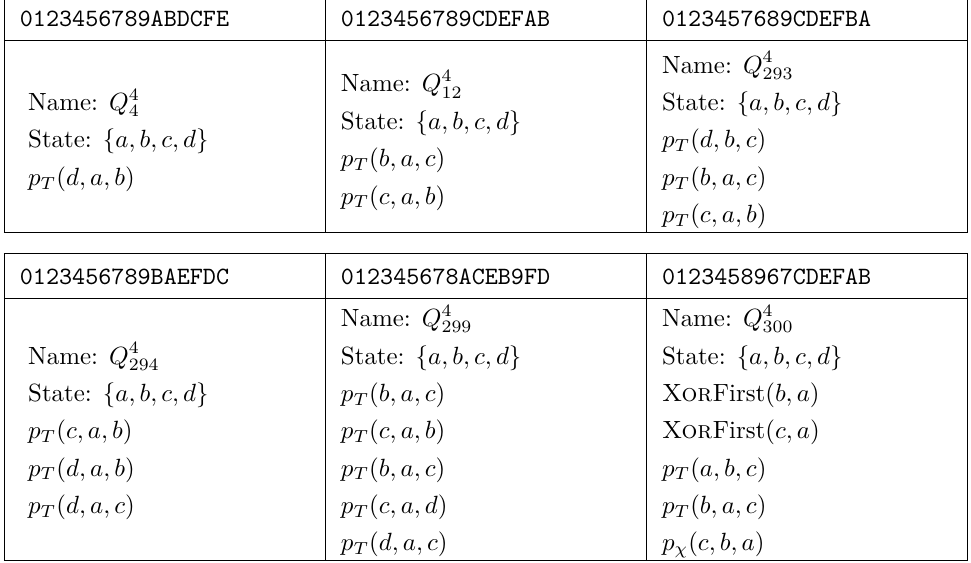
Table 1: The 6 classes of quadratic 4-bit S-boxes [BNN + 15] expressed in terms of p T and p χ